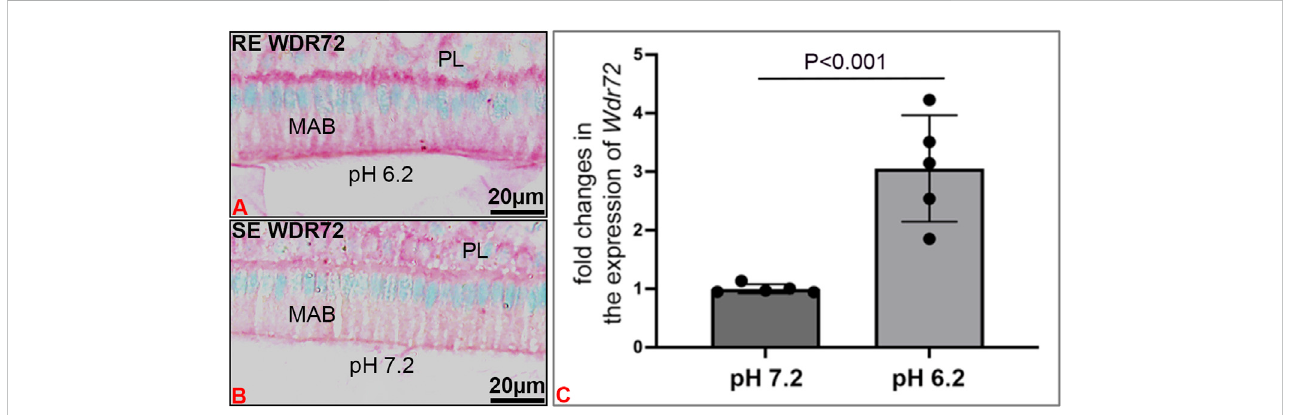
FIGURE 6 pH related effects on WDR72 expression. (A) Immunostaining of wt mouse incisor maturation stage of ameloblasts (MAB) showed increased staining of WDR72 at the basal and apical borders of ruf fl e-ended ameloblasts RE, associated with an acidic enamel matrix (pH 6.2), as compared to (B) Smooth-ended ameloblast SE which are associated with a more neutral matrix (pH 7.2) (C) In vitro , pH related changes in Wdr72 mRNA showed increased expression at pH 6.2 as compared to pH 7.2 (unpaired Student ’ s t-test). N = 5; SDs of individual samples are indicated by the dark circles on the error bar.